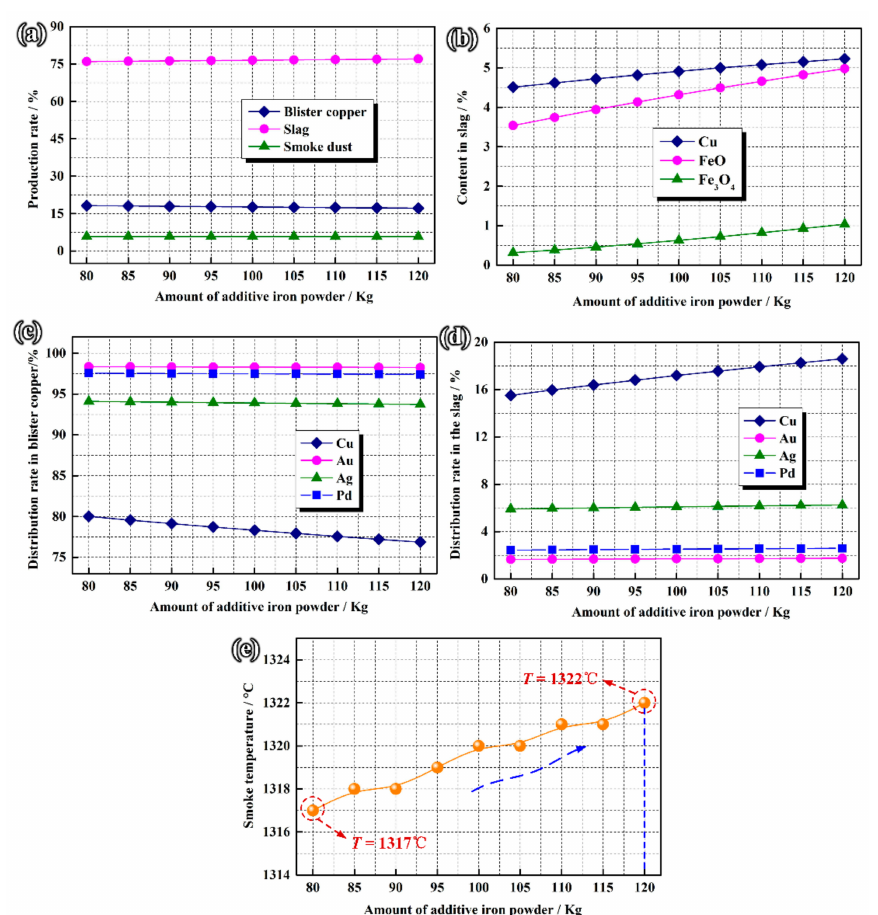
Figure 6. The influence of the amount of additive iron powder on the top-blowing smelting process of electronic waste. ( a ) Production rate of blister copper, slag and smoke dust; ( b ) content in slag; ( c ) distribution rate of various metals in blister copper; ( d ) distribution rate of different metals in the slag; ( e ) smoke